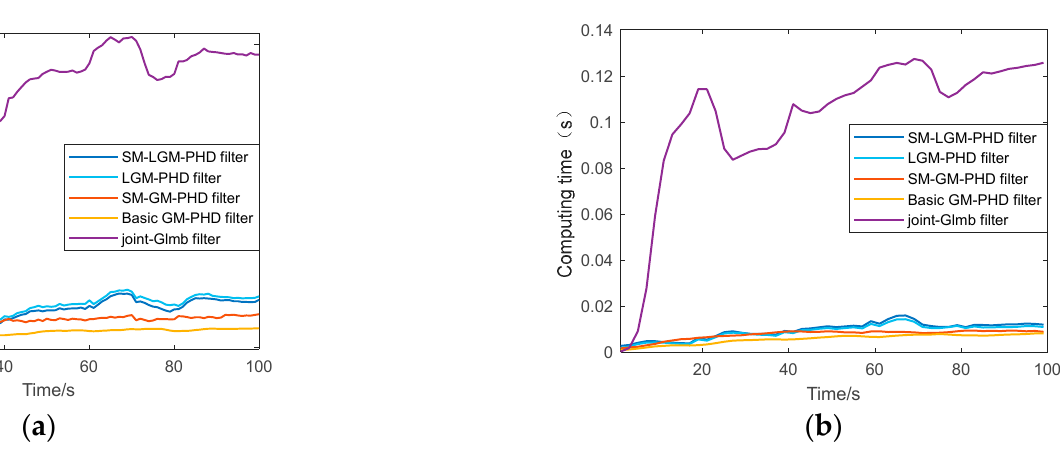
Figure 7. The estimations of the multi-target trajectories and the actual measurements in example 1 (CV motion model) for a sample run. ( a ) The actual measurements, actual trajectories and estimated trajectories obtained after filtering by the SM-GM-PHD filter for T s = 2 s ( T i = 4 ms, λ = 52, p D , k = 0.96). ( b ) The actual measurements, actual trajectories and estimated trajectories obtained after filtering by the SM-LGM-PHD filter for T s = 2 s, and the different trajectories are denoted by different color dots. ( c ) The actual measurements, actual trajectories and estimated trajectories obtained after filtering by the SM-GM-PHD filter in x and y coordinates for T s = 2 s. ( d ) The actual measurements, actual trajectories and estimated trajectories obtained after filtering by the SM-LGM-PHD filter in x and y coordinates for T s = 2 s.